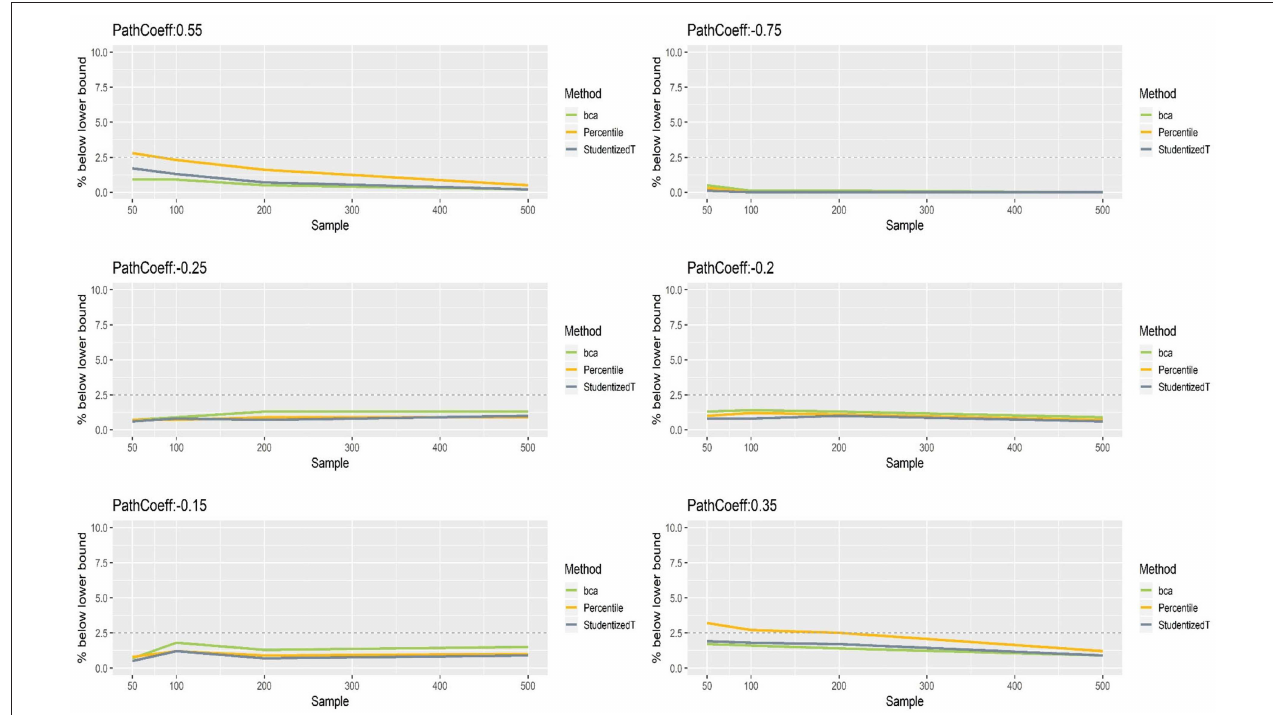
FIGURE 8 | The lower limits of percentile, bias-corrected and accelerated bootstrap (BCa), and Student’s t 95% confidence intervals (CIs) of path coefficients in the non-normally distributed indicator